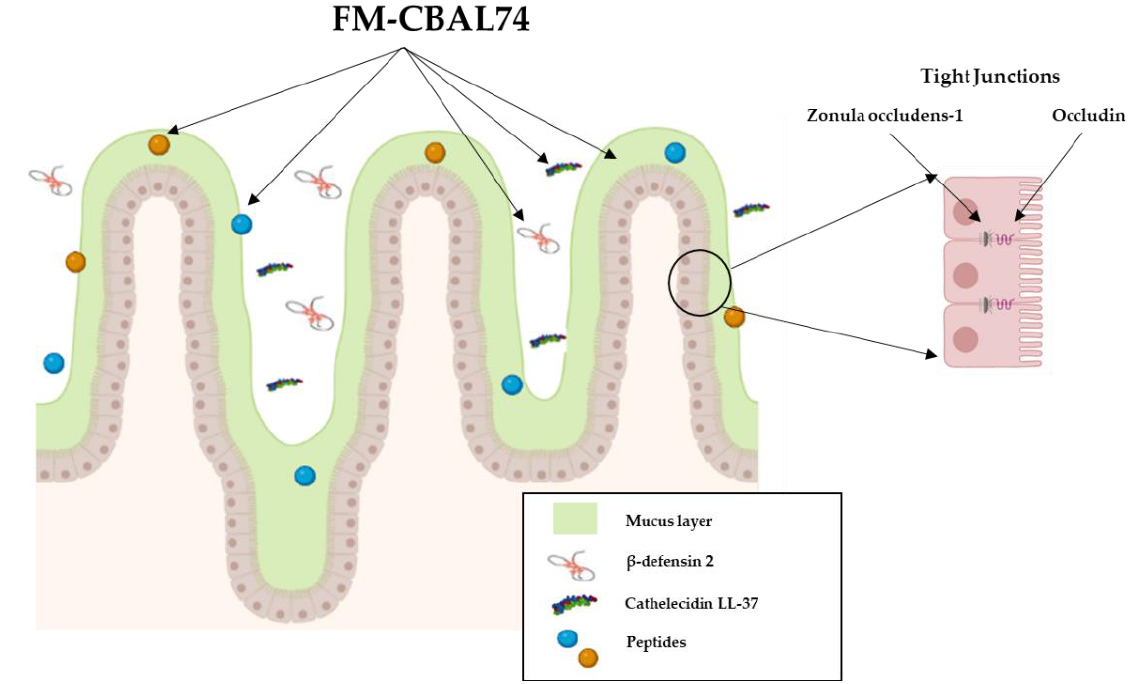
Figure 4. FM-CBAL74 modulates different components of the epithelial gut barrier. FM-CBAL74 promotes a beneficial modulation of epithelial gut barrier structure and function through a stimulation of enterocytes cell growth and differentiation, up-regulation of tight-junction proteins expression (i.e., zonula occludens-1 and occludin), mucus layer thickness (i.e., stimulation of mucin 2 expression), and innate immunity peptides release (i.e., β -defensin-2 and cathelicidin LL-37). 4. Preclinical Evidence on the FM-CBAL74 Effects against Intestinal Viral